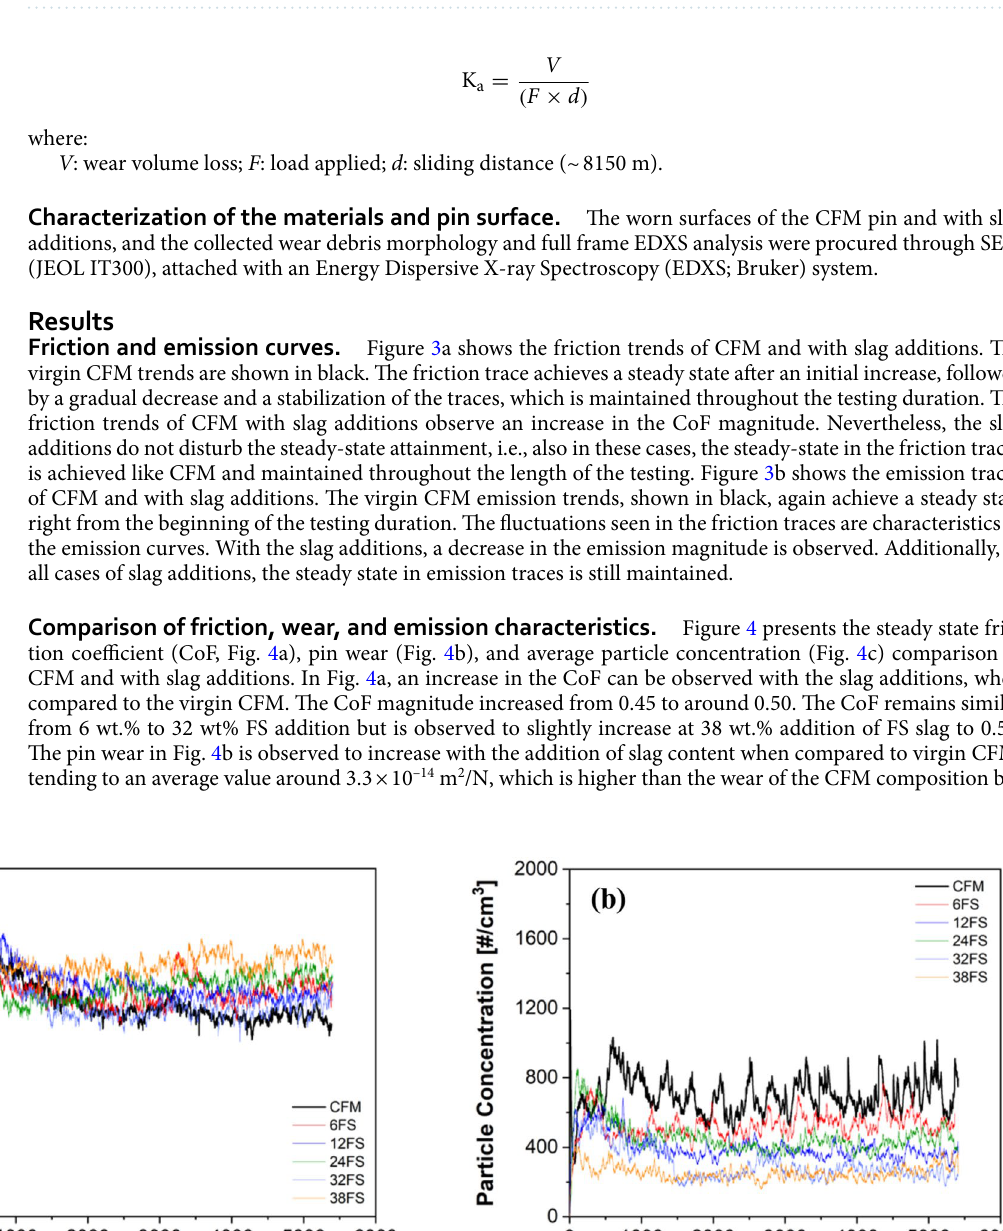
Figure 2. Pin on disc testing apparatus setup (A) Ambient air, (B) Fan, (C) HEPA filter, (D) Air introduced in the chamber, (E) Disc/Counterface, (F) Air outlet to the OPS, (G) Weights.